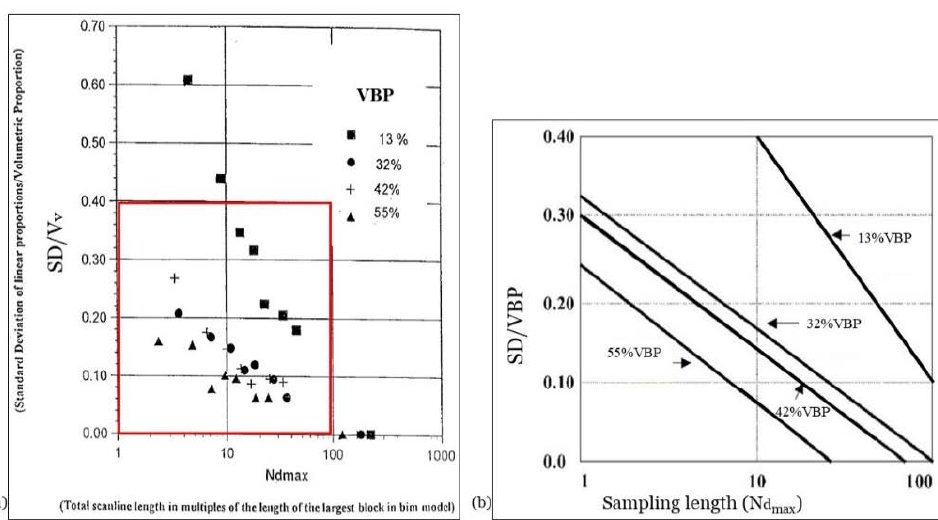
Figure 2. ( a ) Uncertainty (CV) in estimates of the VBP from 1D measurements as a function of the total sampling length (expressed as Nd max or the multiple N of the length of the largest block, d max ) and the measured LBP (modified from [49]); ( b ) portion of Figure 2a (red box), drafted as a design aid, in which trend lines were very approximately mapped through the data points in Figure 2a (modified from [49]).